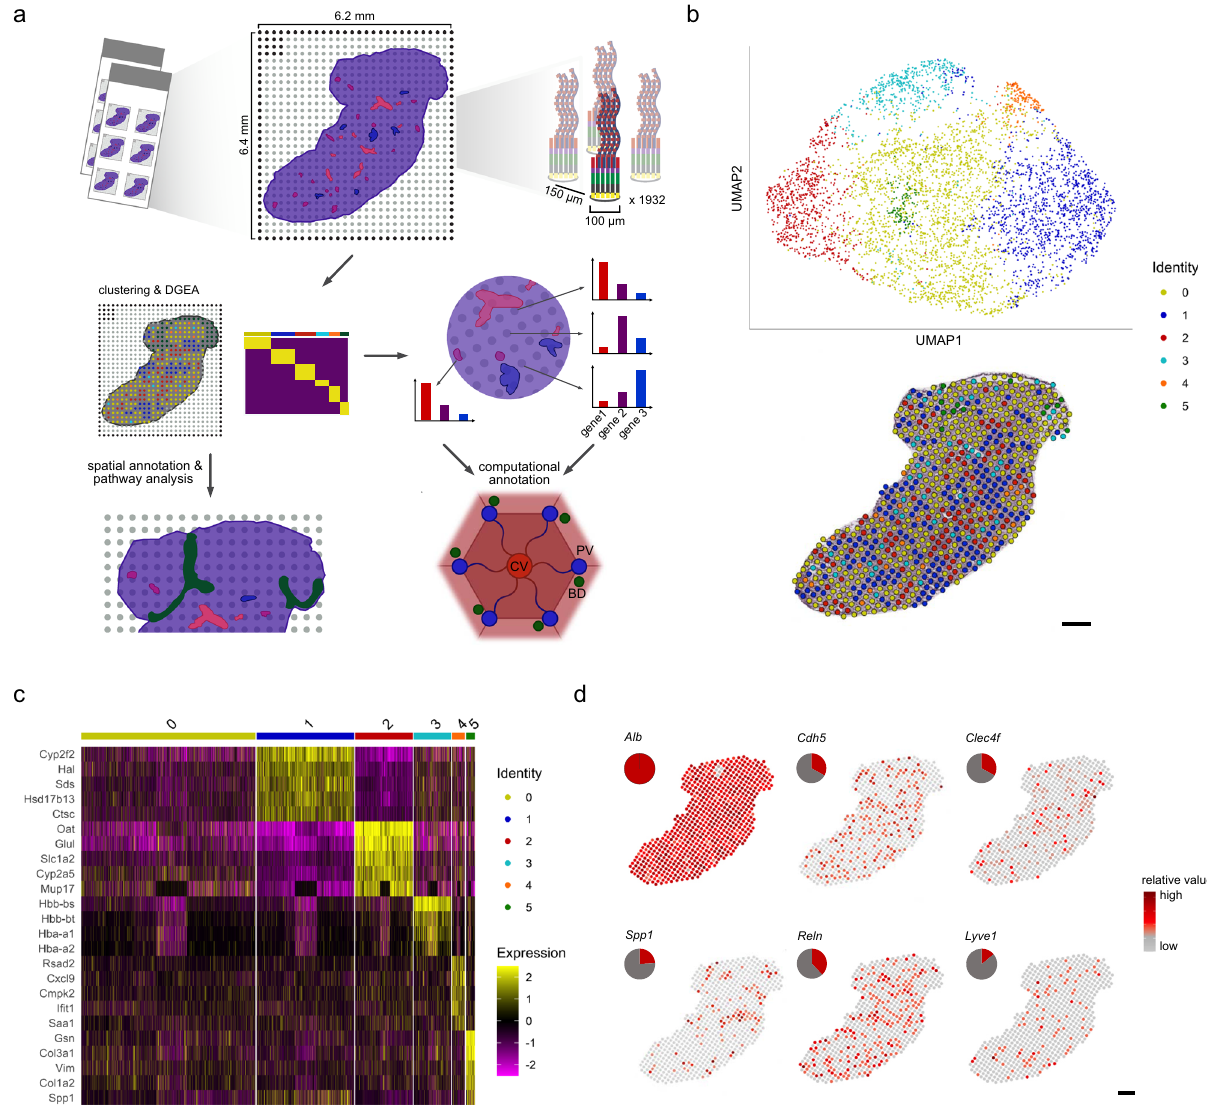
Fig. 1 Study overview of Spatial Transcriptomics on murine liver. a Spatial Transcriptomics was performed on a total of 8 murine liver tissue sections. The tissue sections were placed in one of six, 6.2 × 6.4 mm frames on the glass slide ST array. Each frame contains 1932 spots, with >200 M uniquely barcoded mRNA capture probes. The distance between centers of each neighboring spot is 150 µ m (200 µ m for spots in the same row). Initially, each tissue section was fi xed, stained with hematoxylin and eosin (H&E) and followed by imaging. Then, tissue sections were permeabilized, followed by mRNA capture, tissue removal and sequencing. Thereafter, the count data was subjected to cluster- and differential gene expression analysis (DGEA). The results of the clustering and DGEA were further analyzed and spatially annotated at the global tissue context and down to the lobular level. For new spatial annotations, pathway analysis was performed. Liver lobules are classically described by a central vein (CV, red) surrounded by 6 portal nodes (PV, blue) with neighboring bile-ducts (BD, green). For lobular spatial annotations, clusters have been computationally annotated by comparing expression levels in a set of genetic markers linked to metabolic zonation along the lobular axis. b Canonical correlation analysis (CCA) was performed to integrate data of 8 liver tissue sections, the data was subsequently normalized and subjected to graph-based clustering in which 6 clusters were identi fi ed (see Methods). The integrated data was embedded in UMAP space (top) and depicted as an overlay of the spot cluster annotation across the tissue (bottom) (scale bar indicates 500 µ m). c Heatmap depicting expression values of the fi ve most variable genes for each cluster after subjecting the 6 clusters to DGEA, with the exception of cluster 3, which resulted in only four signi fi cantly differentially expressed genes and cluster 0 which did not result in any signi fi cantly differentially expressed genes with the given parameters (Methods). d Visualization of spatial distribution of reported expression markers of Hepatocytes ( Alb ), liver endothelial cells ( Cdh5 ), Kupffer cells ( Clec4f ), Cholangiocytes ( Spp1 ), hepatic stellate cells ( Reln ) and lymphatic liver endothelial cells ( Lyve1 ) by spots under the tissue. Pie-charts indicate the respective proportion of cell type markers present in spots under the tissue (scale bar indicates 500 µ clusters, we performed differential gene expression analysis The projection showed a clear spatial segregation between (DGEA) between them. In fact, DEGs in cluster 1 support spots belonging to certain clusters. Visual inspection showed that periportal gene expression from previous studies while genes cluster 5 was localized to an exclusive region of the tissue section, previously associated with pericentral gene expression are while spots belonging to cluster 1 and cluster 2 aligned with the enriched in cluster 2, proposing that cluster 1 and cluster 2 vascular structures in the liver tissue (Fig. 1b, lower panel, denote regions around the portal and central veins, Supplementary Fig. 3). To further characterize the identi fi ed